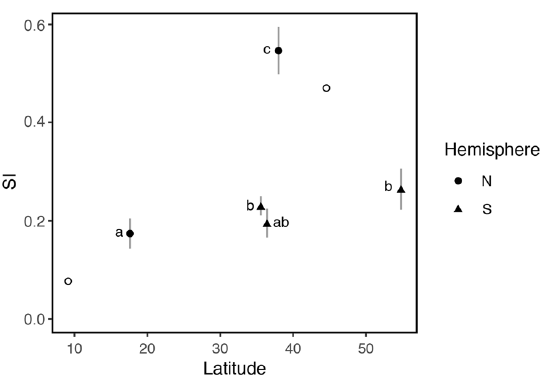
Figure 2. Latitudinal variation in population synchrony index (SI, calculated following 49 ). X axis: absolute latitude; Y axis: SI. Open symbols represent population means taken from previously published studies; filled symbols represent the population means calculated by the model for the data used in this study (n = 406, from 5 different populations). Lines represent the 95% confidence intervals for the different SIs estimated. Populations from the North hemisphere are represented by circles, populations from the South hemisphere are represented by triangles. Symbols with different letters have statistically different SI